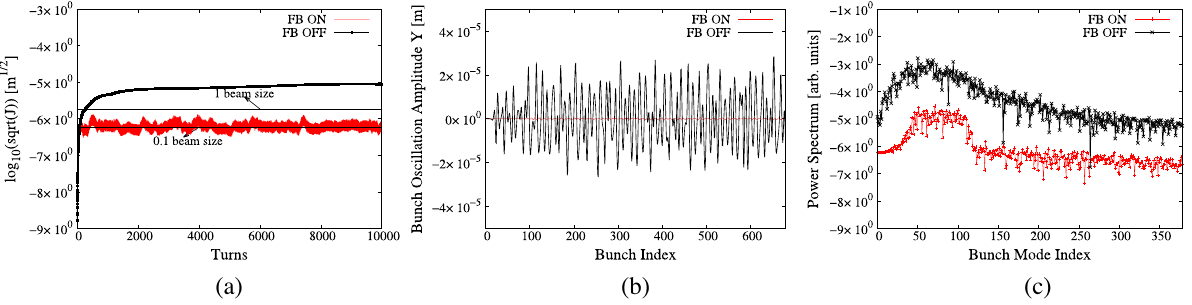
FIG. 12. The red and black curves show the maximum beam actions during 10000 turns evolution (a), the beam bunch oscillations at the 500th turn (b), and the related coupled bunch mode power spectrum (c) in the vertical plane with and without bunch-by-bunch feedback. The results are obtained from the weak-strong model taking synchrotron radiation damping and quantum excitation into account.